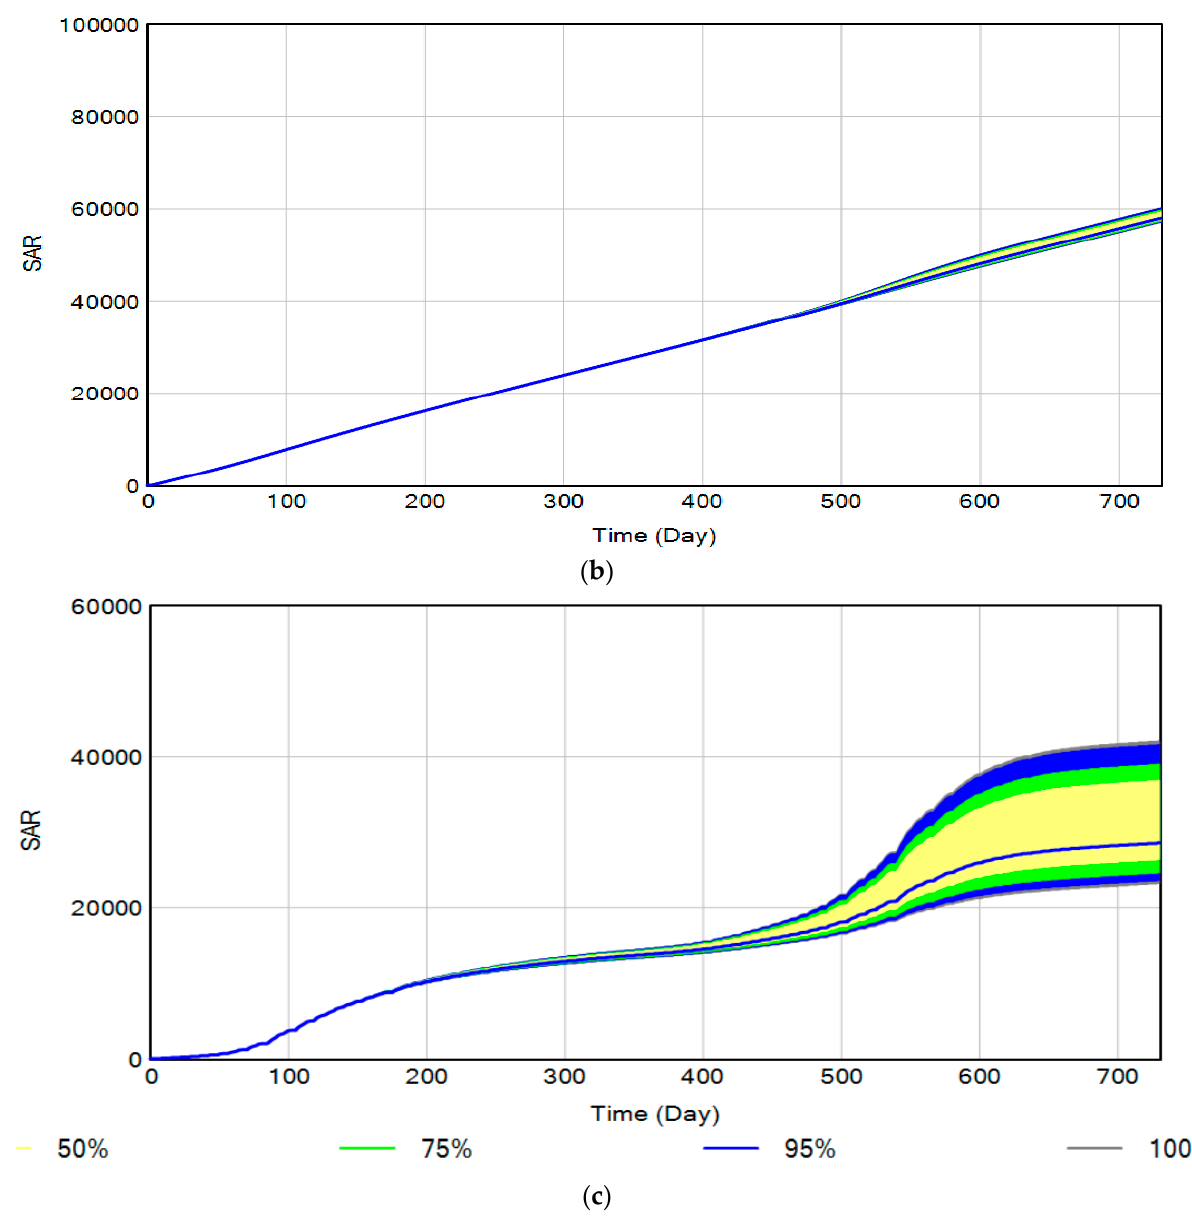
Figure 7. Total inventory management cost sensitivity graphs under the influence of social awareness impact for policies ( a ) POP ( b ) JIT and ( c ) ROP.